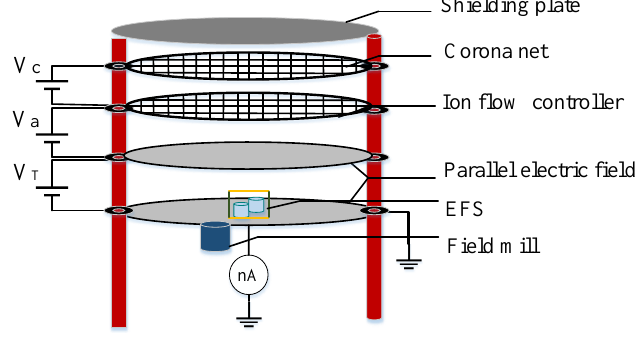
Figure 8. The structure of the ion flow generator.